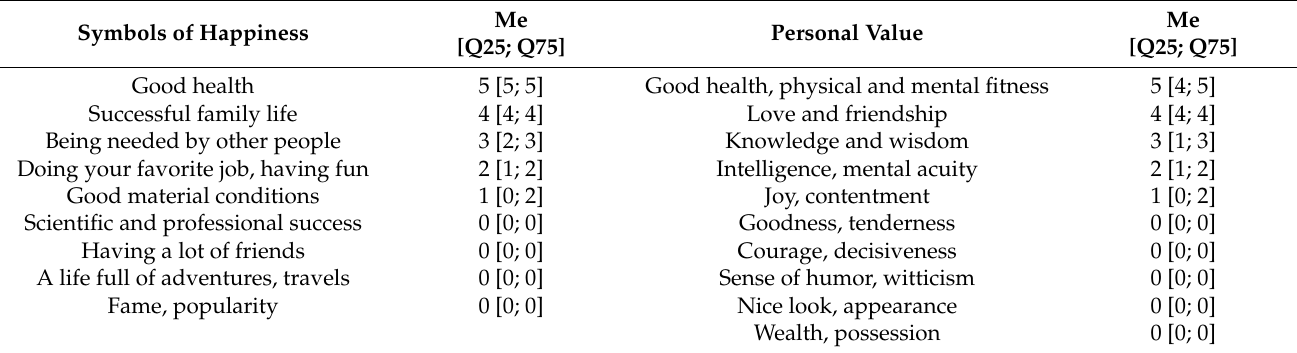
Table 2. The list of personal values ( n =